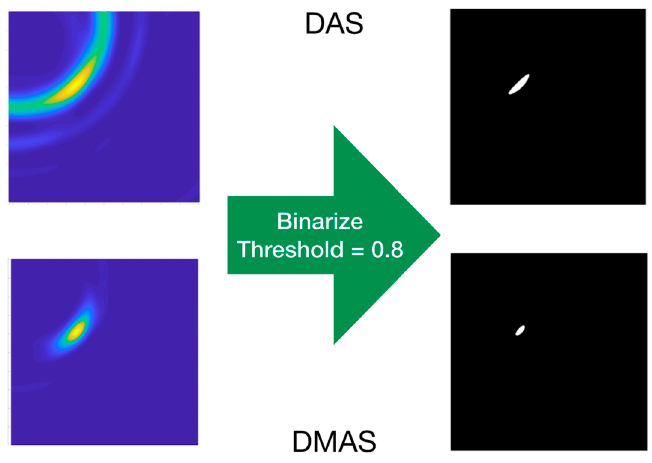
Figure 15. Example of the binarization process for “p5–p4” images.